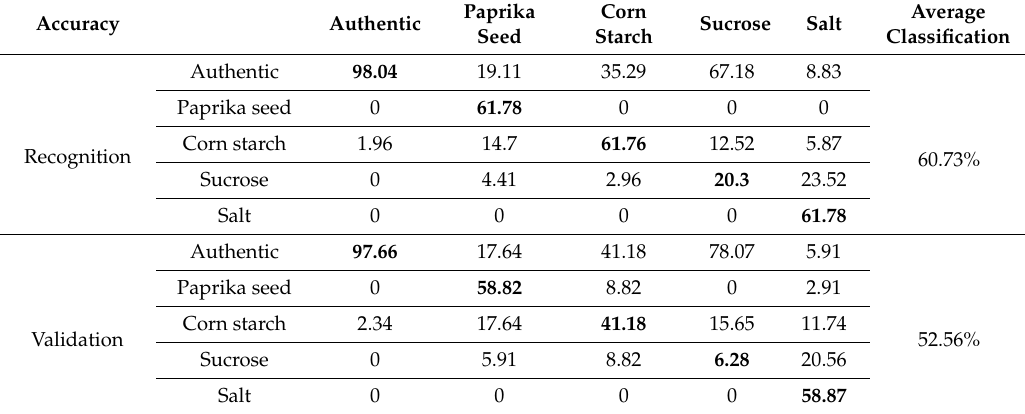
Figure 5. LDA classification model on the whole e-tongue dataset (N = 262) after drift correction, outlier detection and triple cross-validation: ( a ) LDA plot when the adulterant type was used as class variable (C0–C5 present the adulterant concentration); ( b ) LDA plot when the adulterant concentration was used as class variable. Table 9. LDA classifications after e-tongue data drift correction, outlier detection and three-fold cross—validation when the adulterant type was used as class variable.